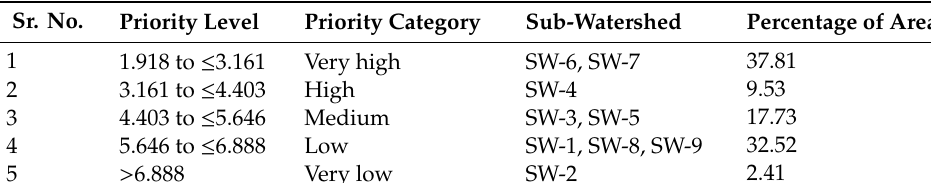
Table 13. Priority category of nine sub-watersheds based on CF value [1,22].